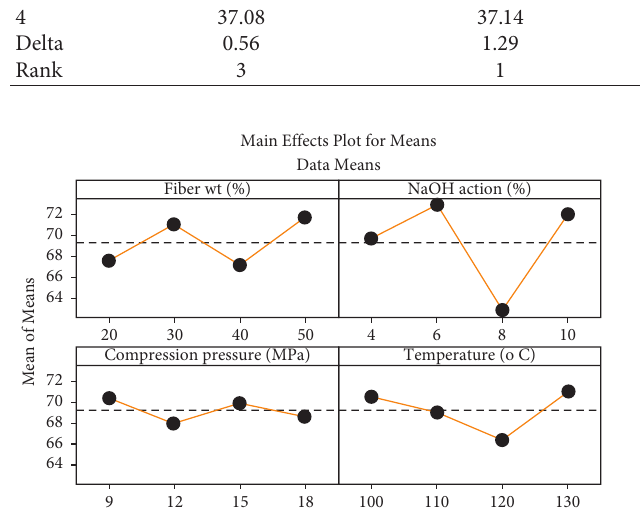
Figure 5: Main effect plot for means to flexural strength.